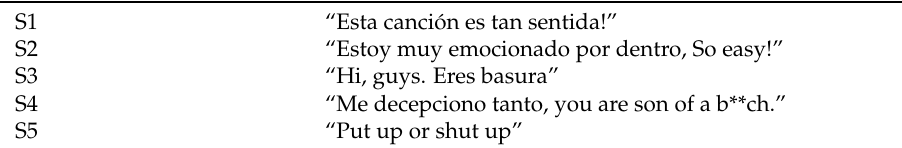
Table 1. Online comment